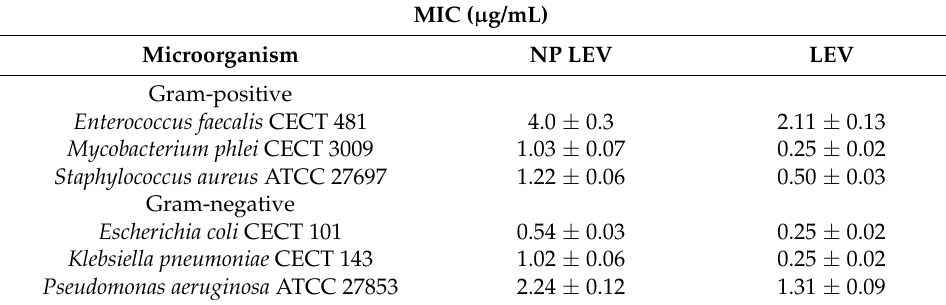
Figure 3. TEM image of PLGA (DESE, DCM) nanoparticles. Table 4. Minimum inhibitory concentration (MIC), for the PLGA (DESE, DCM) levofloxacin (LEV) loaded nanoparticles, nanoparticle (NP) LEV, and free antibiotic, LEV, expressed as µg/mL. Experiments were performed in duplicate and the mean MIC value was reported (experimental results are expressed as the mean ± SD, n = 3).